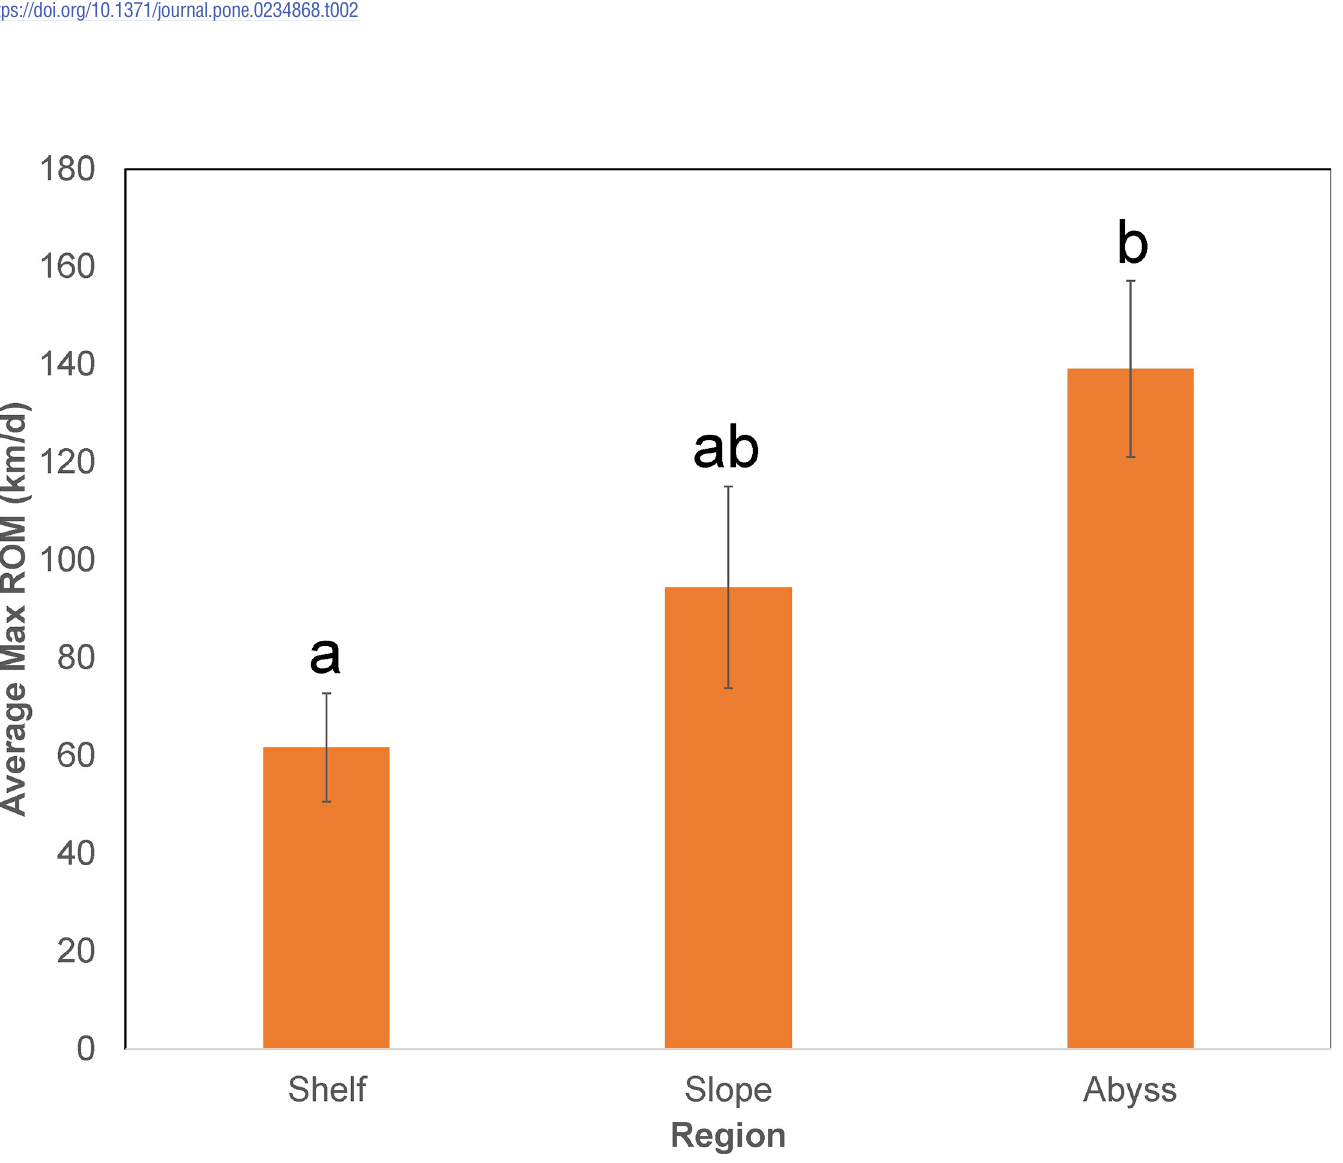
Fig 5. Vertical bar chart of average maximum rate rate of movement by region. Data are presented across continental zones in the GoM. Error bars represent standard errors of the mean and letters designate statistically significant groups as revealed by Tukey’s pairwise comparisons. Regions that share at least one letter are not significantly different from one another (i.e,. P > 0.05), whereas those that do not share a letter are statistically distinct (i.e., P < 0.05).